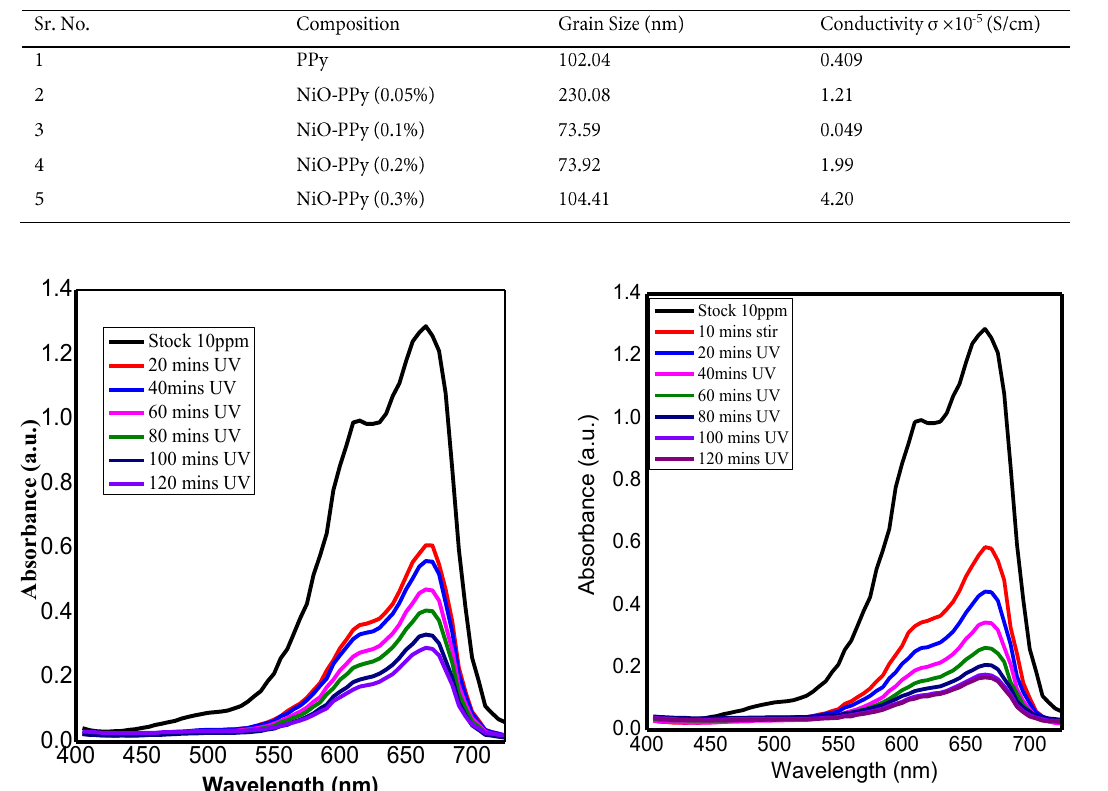
Fig. 5. The absorption spectra of the Methylene blue solution in presence of NiO-PPy catalyst under solar light irradiation. blue degradation under UV irradiation.